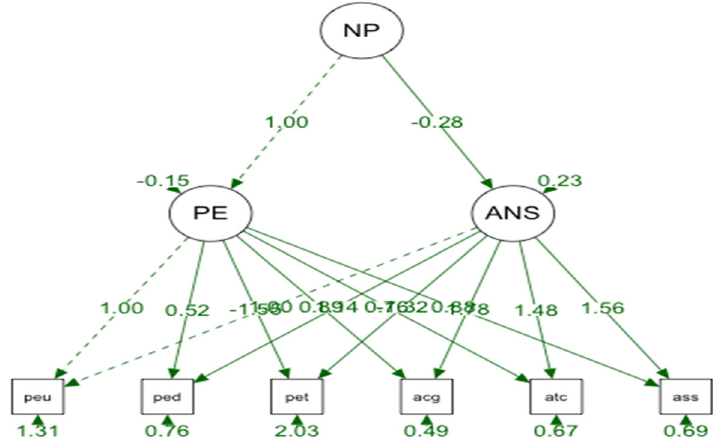
Figure 2. Structural equation model.